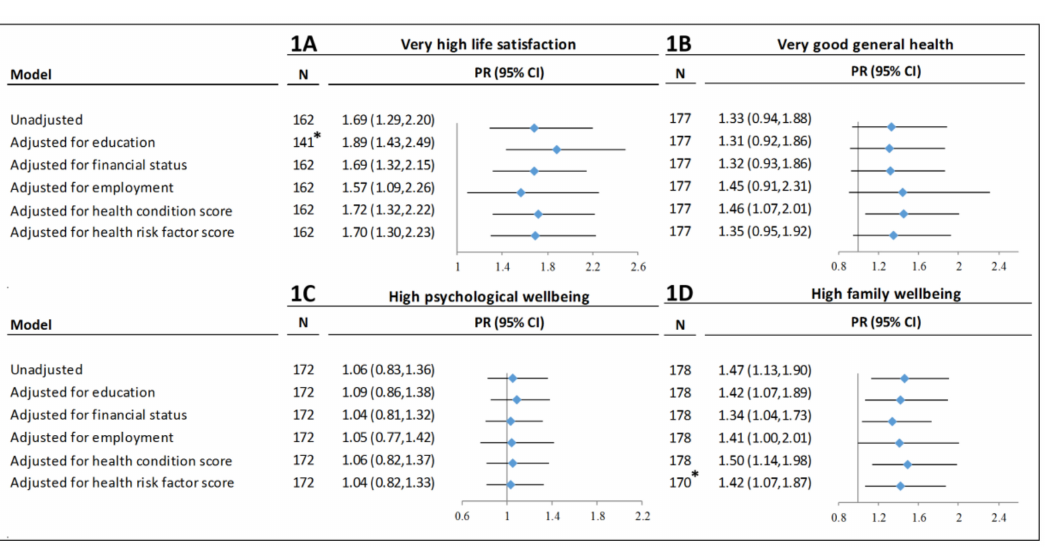
Figure 1. Associations between Ranger status and wellbeing measures. PR = Prevalence Ratio. * Missing category for relevant exposure variable was excluded due to zero